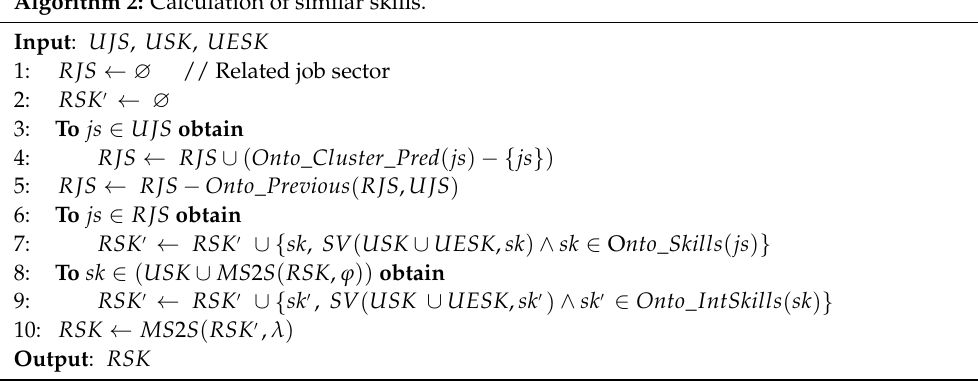
Algorithm 2: Calculation of similar